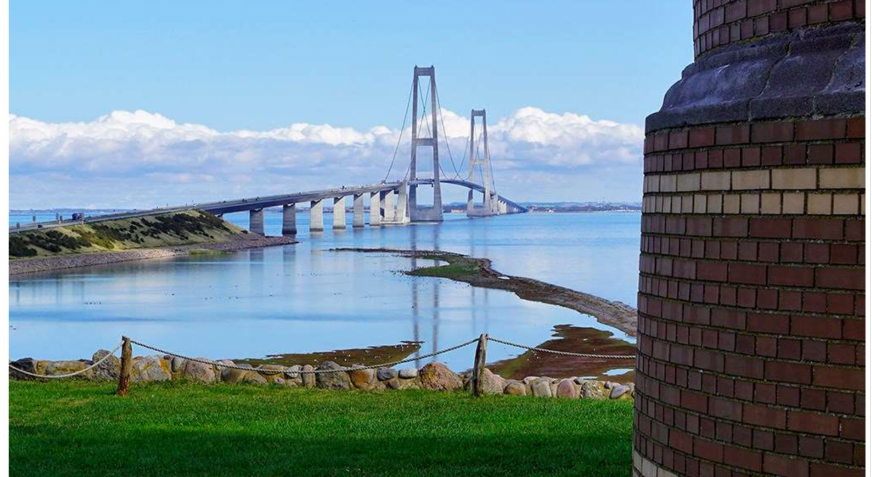
Figure 3. The Great Belt Bridge in Denmark